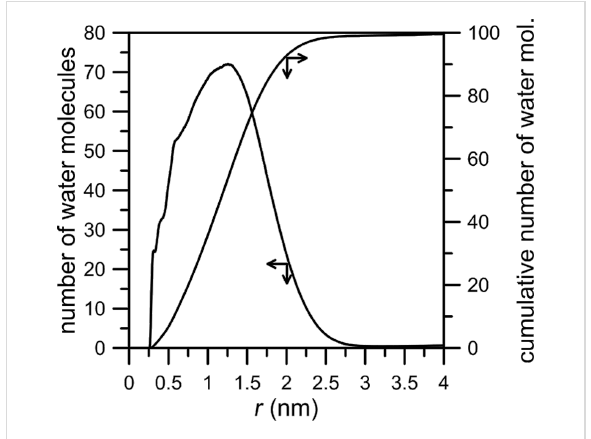
Figure 8: The number of water molecules plotted as a function of the distance of O w atoms from the center of the rim of an NN nanopore (defined as the geometric center of nitrogen atoms in the nanopore rim) calculated for a CH 4 + N 2 gaseous mixture containing 200 water molecules. Other notes are the same as in Figure